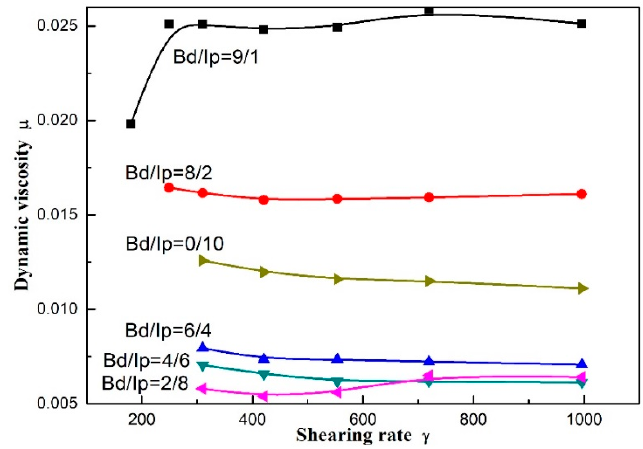
Figure 8. Dynamic viscosity against shearing rate of butadiene-isoprene copolymers synthesized by the coordination polymerization at different Bd:Ip mole ratios from 9:1 to 2:8. Polymerization conditions: TNPP:Mo = 6, Al:[M] = 5, Mo:[M] = 8 × 10 − 4 , [M] = 0.18 g · mL − 1 , T = 60 ◦ C, t = 7